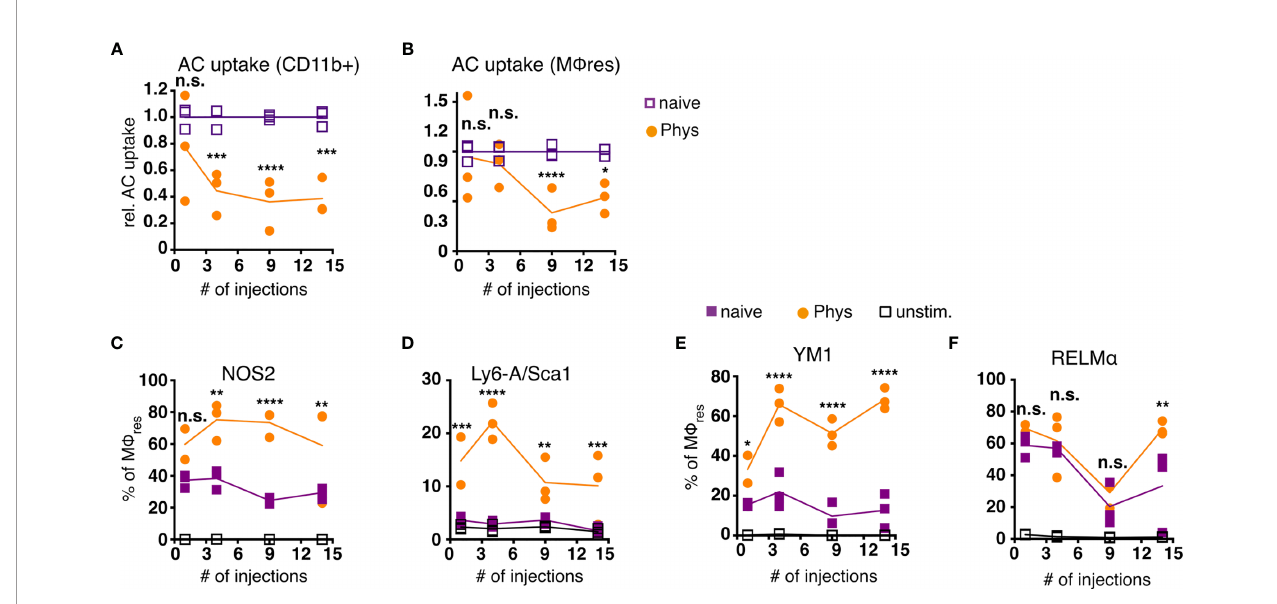
FIGURE 5 | M F res from PD fl uid-injected animals show progressively enhanced responses to stimulation. C57BL/6 mice were injected with PD fl uid (circles) or left untreated (squares) 5 times a week for the indicated number of injections. At each timepoint whole PEC were isolated 24 h after the last injection and incubated in vitro in the presence of pHrodo labelled apoptotic thymocytes for 90 minutes (A, B) or stimulated with LPS/IFN g ( C, D ; 6 h) or recombinant IL-4 ( E, F ; 24 h) as a control non-stimulated cells (open squares) were used. Uptake of apoptotic cells by total CD11b+ myeloid cells (A) or M F res (CD102+I-A/I-E low) (B) as well as expression of M F res associated cell-surface markers (C – F) assessed by fl ow cytometry. Datapoints depict individual animals and lines indicate mean and SD. Data from a single experiment. Data analysed using 2-way ANOVA followed by Tukey ’ s post-hoc test after transformation. n.s., not signi fi cant; *p < 0.05; **p < 0.01; ***p<0.001; ****p <